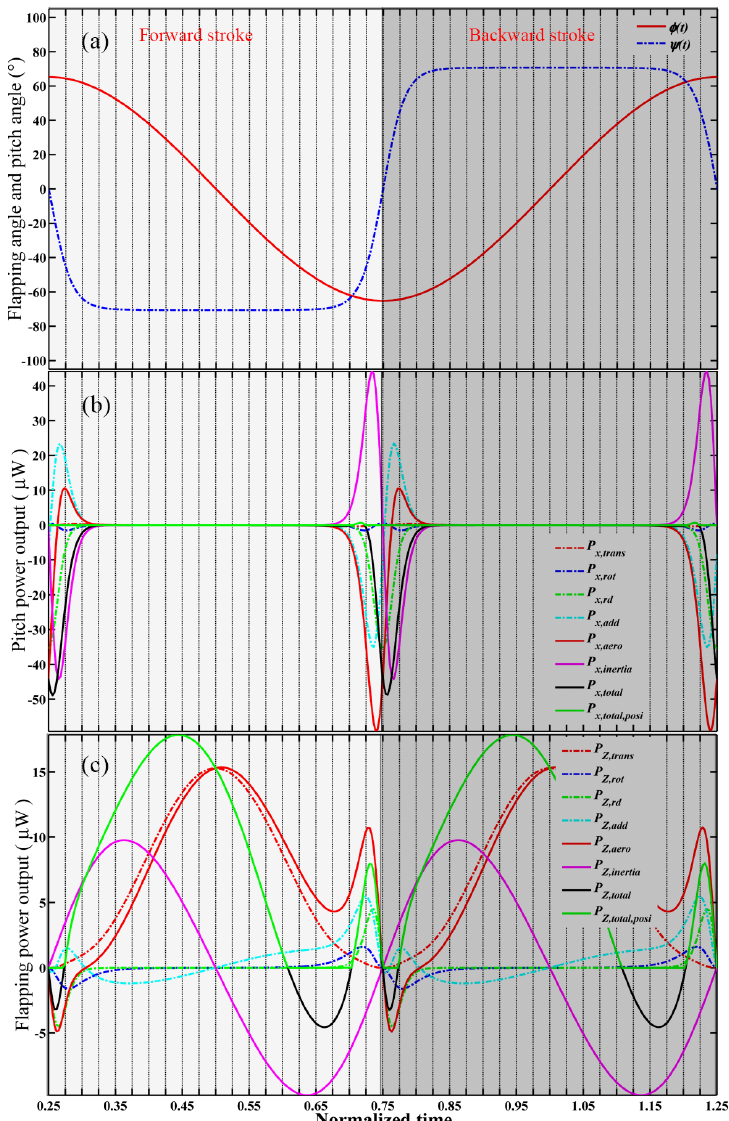
Figure 9. Wingbeat motion ( a ), pitch and flapping power output of single wing ( b , c ) for optimal WKP.